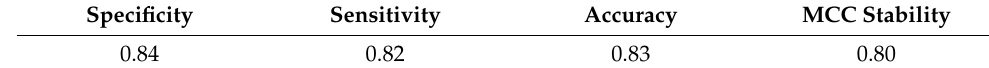
Table 6. Scores for Independent dataset testing of the proposed method.